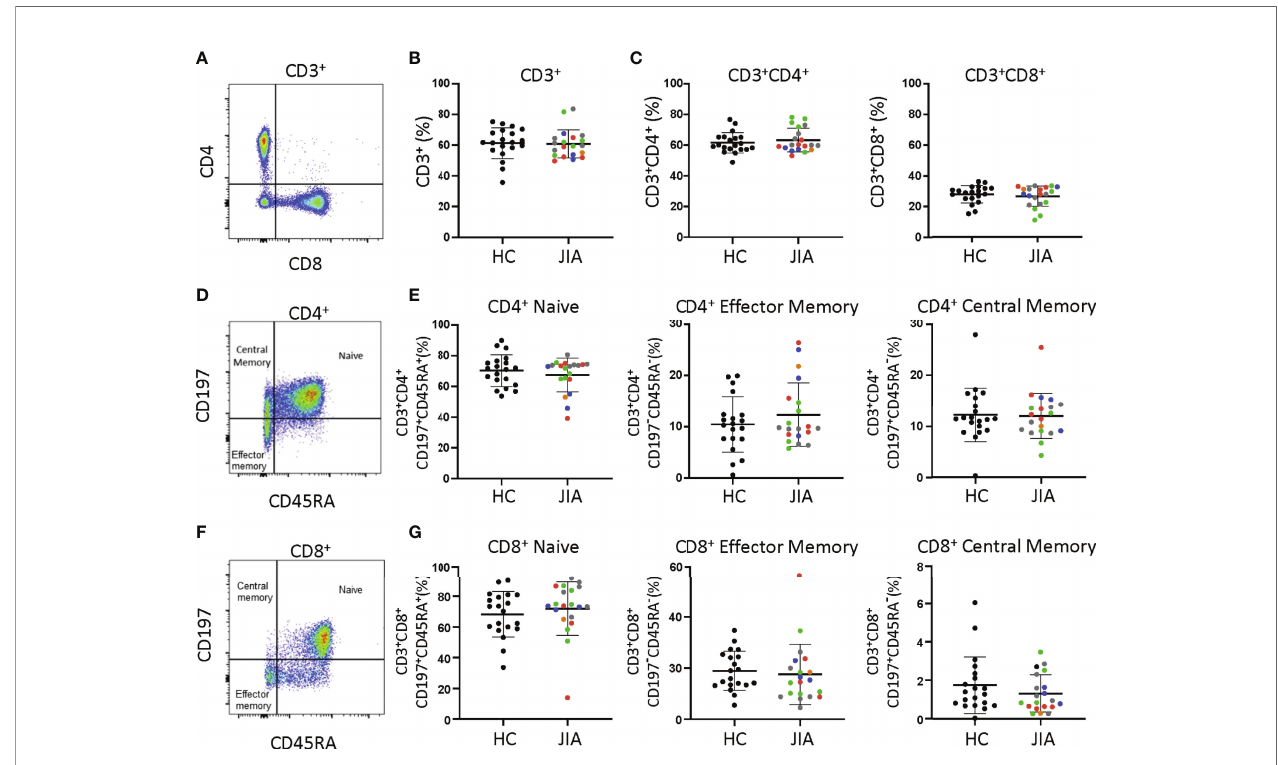
FIGURE 1 | T cell subsets from child healthy control (HC) and JIA are the same. HC and JIA PBMCs analyzed with fl ow cytometry for CD3 + , CD3 + CD4 + , and CD3 + CD8 + cells and for naïve (CD197 + CD45RA + ), central memory (CD197 + CD45RA - ), and effector memory (CD197 - CD45RA - ) cell subsets. JIA are colored based on current use of methotrexate (green), biologic (blue), methotrexate and biologic (gray), prednisone (orange), and none or NSAID (red). (A) Representative fl ow cytometry plot of CD3 + cells. (B) Analysis of CD3 + cell frequency. (C) Analysis of CD3 + CD4 + and CD3 + CD8 + cell frequencies. (D) Representative fl ow cytometry plot of CD3 + CD4 + cells. (E) Analysis of naïve, effector memory, and central memory frequency of CD3 + CD4 + cells. (F) Representative fl ow cytometry plot of CD3 + CD8 + cells. (G) Analysis of naïve, effector memory, and central memory frequency of CD3 + CD8 + cells. HC (N=20) and JIA (N=20). Shown is mean with standard deviation. Analysis by Welch ’ s t-test. No signi fi cant